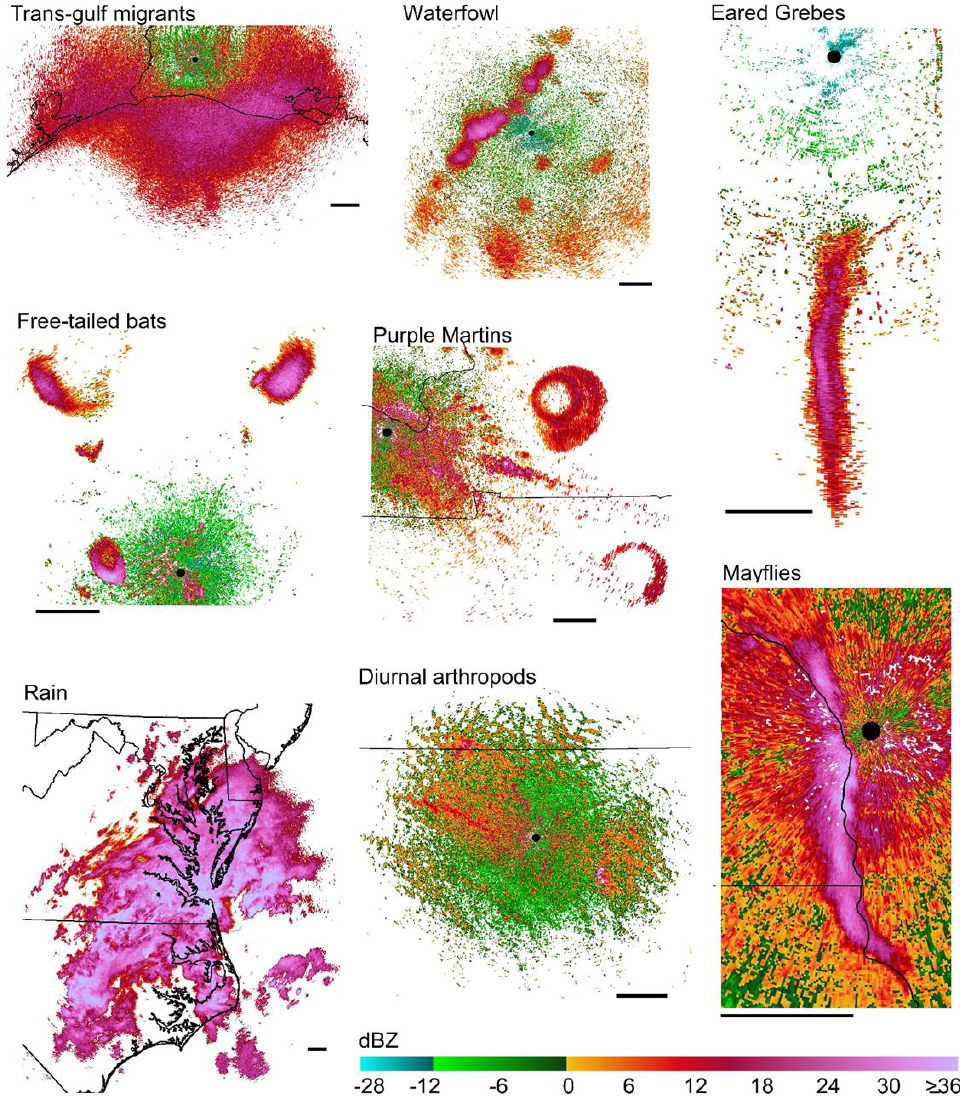
Figure A1. Examples of different scatterer types used in this paper shown in radar reflectivity factor. The radar call signs, dates, and times associated with each scatterer type are: Trans-gulf migrants, KLCH, 6 May 2014, 1707 CST; Waterfowl, KILX, 9 Nov 2016, 1756 CST; Eared Grebes, KMTX, 26 Nov 2014, 1931 MST; Free-tailed bats, KEWX, 3 Jul 2016, 1944 CST; Purple Martins, KPAH, 15 Aug 2014, 0507 CST; Rain, KAKQ, 8 Sep 2014, 1505 EST; Diurnal arthropods, KABR, 22 Jun 2014, 1755 CST; and Mayflies, KARX, 27 Jul 2015, 2028 CST. Black lines show US state boundaries, black dots mark the location of radars, and black bars associated with each image are scaled to 30 km. All imagery is oriented to true north.